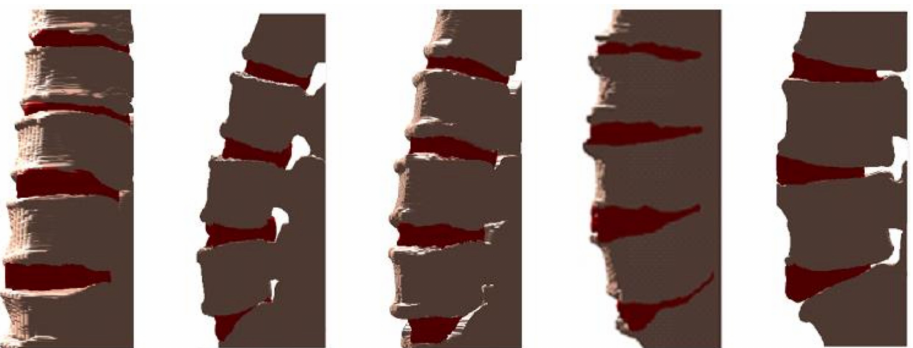
Figure 13. Example visualizations obtained by the proposed method, marking vertebrae and IVDs with gray and red,